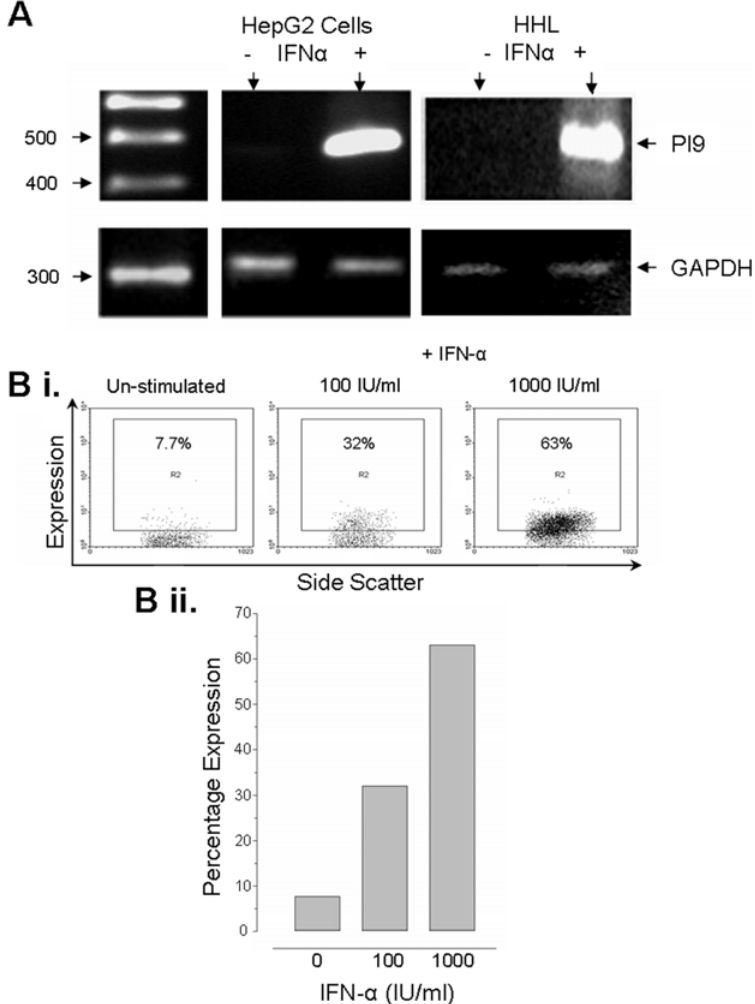
Figure 7. Expression of the granzyme B inhibitor, serine proteinase inhibitor 9 (PI-9). A ) RT-PCR revealed that IFN- a stimulated cells, HepG2 and HHL-9 cells, were able to upregulate PI-9. GAPDH expression was analysed as a positive control. Bi and ii ) This was confirmed by FACS analysis as described in the methods and materials. Upregulation of PI-9 was shown to be dose dependent.